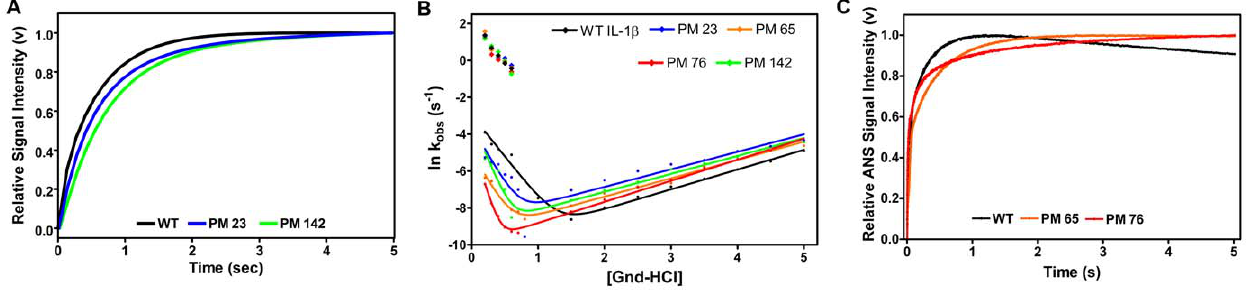
Figure 4. Representative traces of the folding kinetics and chevron plot of the relaxation rates indicating the effects of altered chain connectivity. (A) WT IL-1 b is in black, PM23 in blue, and PM142 is in green. The traces are of the first 5 seconds of stopped-flow kinetic refolding jumps from 2.2 M Gdn-HCl to 0.4 M Gdn-HCl. Kinetic curves of WT and permutant proteins were fit to a three-exponential model. (B) Plot of the natural log of k obs obtained by both stopped-flow and manual mixing refolding and unfolding experiments for all proteins variants as a function of final denaturant concentration. A comparison of the observed relaxation rates obtained by stopped-flow refolding experiments associated with the formation of the intermediate (upper left, diamonds) for WT IL-1 b (black) indicating the similarities in observed rates of intermediate formation between PM23 (blue), PM65 (orange), PM76 (red), and PM142 (green). The data points (lower left and right, circles) and fits depict the rate of formation of the native protein. The differences in slope of the curves are a result of the cut site, where the greatest change in folding is seen in PM76 (red), indicating a slow transition to native. (C) ANS stopped-flow fluorescence-detected refolding of WT and permutant IL-1 b . WT, in black, and permutant IL-1 b protein (PM65 in orange, PM76 in red) were refolded from an unfolded state in the presence of ANS. The traces are representative of refolding jumps from 2.2 M to 0.3 M Gdn-HCl. The first 5 seconds is shown for clarity. The resulting curves confirm the similarity in the formation of the kinetic intermediate, but indicate a change in the release of the